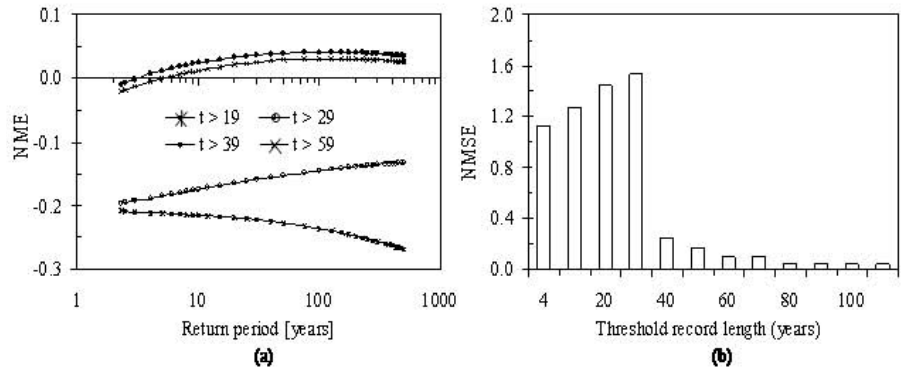
Fig. 10. NME (a) in estimating AMF for the regionalisation, based on L -moment method for the threshold record length ( t ) ranges: asterisks ( t > 19: t = 20 to 116); circle ( t > 29: t = 30 to 116); full circle ( t > 39: t = 40 to 116); crosses ( t > 59: t = 60 to 116). NMSE (b) in estimating the MAF using the jack-knifing principle for record length ranging from 4 to 116yr. GEV distribution and L -moments (and their ratios) were